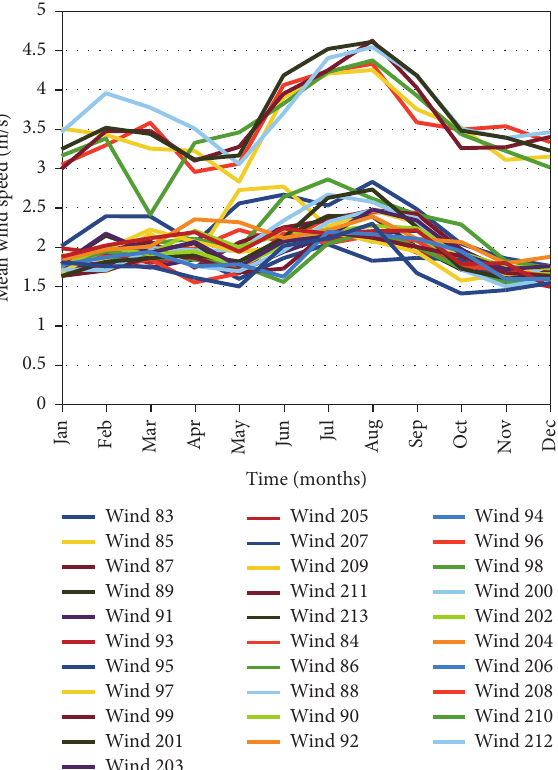
Figure 3: Plot of monthly average wind speed distribution over Debuncha for 31 years’